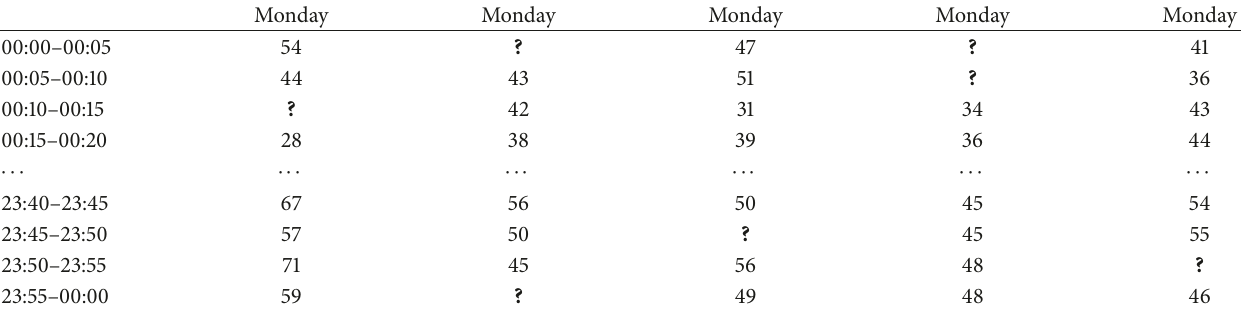
Table 1: A matrix-based missing data representation for “day pattern.”